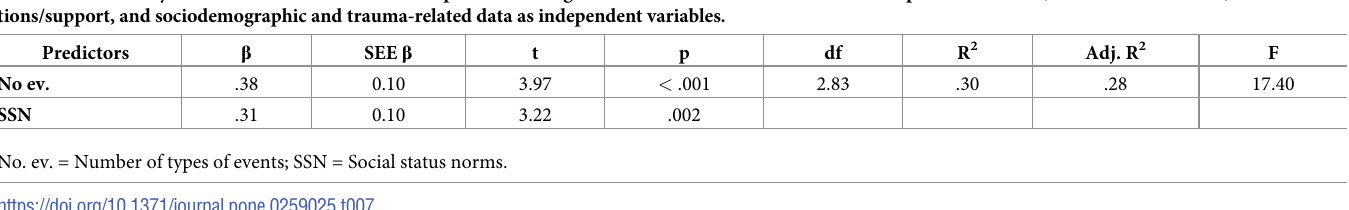
In traditionally masculine societies, such as Poland [67], the positive self-concept may be strongly associated with conforming to cultural standards/norms of masculinity [68]. Sanc- tioning hegemonic masculinity [69,70] makes it necessary to meet the criteria of masculinity and constantly confirm one’s role [71]. These results might be interpreted in the following way: male role norms may be associated with the reinforcement of certain beliefs (e.g. concern- ing emotions in general, the ways of (not) expressing them, about the irrelevance of safety and health in general) [72–74] that reduce one’s ability to adaptively process and regulate emotions in the face of potentially traumatic events. This result seems to be in accord with the so-called “Male Normative Alexithymia Hypothesis” [75], according to which lifelong conformity to the masculine norms pertaining to restrictive emotionality reduces the chances of obtaining abili- ties to properly identify and describe emotional states. Such an interpretation of the observed associations seems to be supported by the etiology of PTSD proposed by Foa & Kozak [76] and Berke, Reidy & Zeichner’s model of masculinity and men’s psychopathology [47]. This assumption can be further reinforced by the observed positive association between avoidance symptoms of PTSD and traditional male role norms (except for anti-femininity norms). Simi- lar results were found in the study conducted by Elder and associates [46]. It is worth mention- ing that no significant association has been observed between anti-femininity norms and symptoms of PTSD in the current study. This might mean that complying with anti-femininity norms might not be related to increased PTSD symptomatology—so only social status and toughness norms seem to reinforce maladaptive enough strategies/behaviors that significantly contribute to the development of PTSD symptoms in the face of potentially traumatic stimuli.